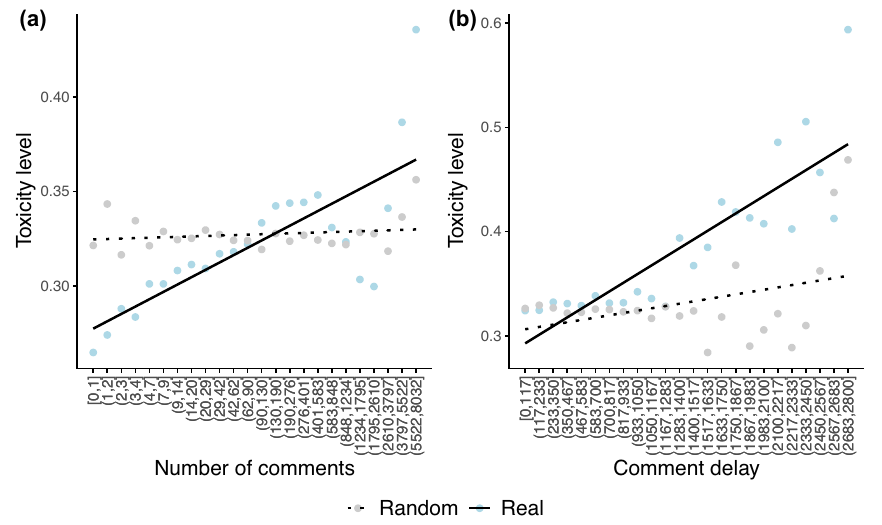
Figure 7. Linear regression models for number of comments and comment delay. On the x-axis of panel ( a ) the comments are grouped in logarithmic bins while on the x-axis of panel ( b ) the comment delays are grouped in linear